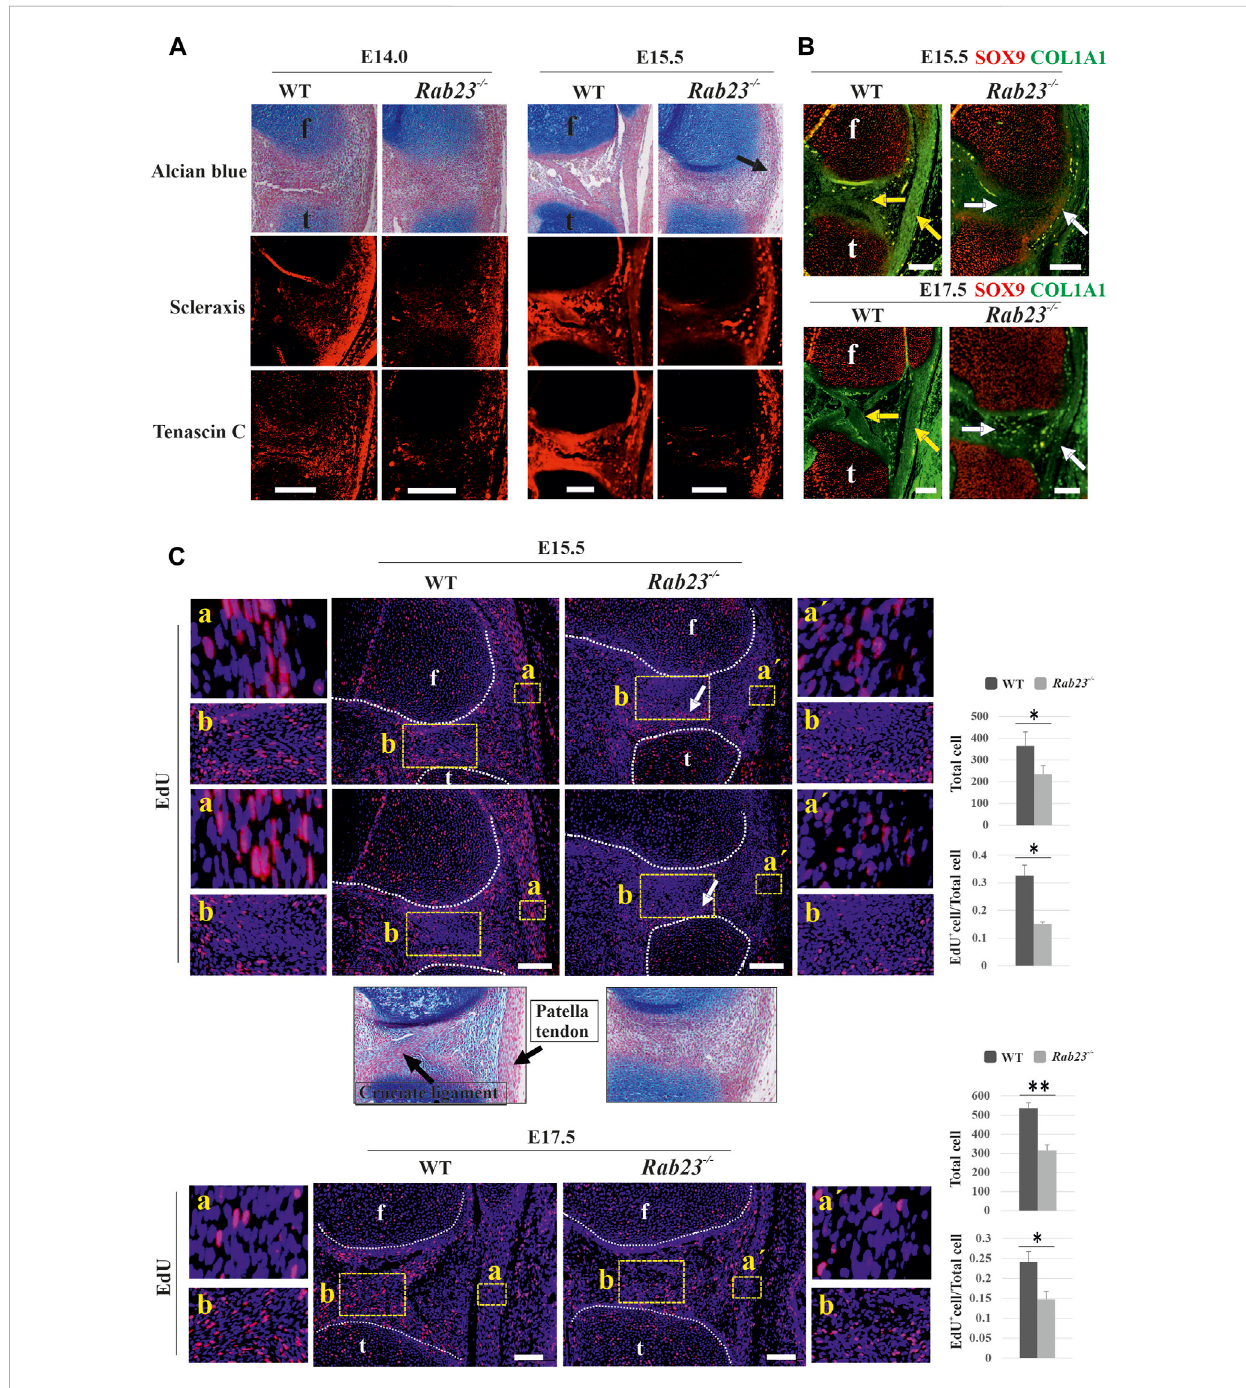
FIGURE 6 RAB23 regulates tendonogenesis and ligamentogenesis and cell proliferation in the patella tendon and cruciate ligaments. (A) Immunohistochemical expression analysis of early tenocyte-expressing marker Scx and structural protein marker Tenascin-C in the Wt and Rab23 − / − mice in the sagittal sections of hind limbs obtained from E14.0 and E15.5. Wt samples show Scx and Tenascin-C expression in the patella tendon at both the embryonic stages, where Tenascin-C con fi rms well-developed patella tendon. Rab23 − / − samples at E14.0 shows less Scx expression in the patella tendon-like structure, and as Rab23 − / − samples at E15.5 failed to develop patella and patella tendon, a musculostructure connected the femur to the tibia (arrow). Scx is expressed in this structure; however, subsequent Tenascin-C expression revealed that musculostructures are disrupted in Rab23 − / − samples. Similar to patella tendon, analysis of Scx and Tenascin-C expressions in the cruciate ligaments show that in Wt samples, both markers areexpressedwelltomarkthecruciateligaments.However,bothmarkersfailedtomarkcruciateligamentsin Rab23 − / − samples.Tohighlightthecartilage cellsofthepatella,patellatendonsagittalsectionsfromE14.0andE15.5hindlimbswerestainedwithAlcianblueandfastred(upperpanel)( n =3samples foreachageandgenotype).f:femurandt:tibia.Scalebar:200 μ m. (B) ImmunohistochemicalexpressionanalysisofSOX9andstructuralintegrityprotein of tendon and ligaments COL1A1 in the Wt and Rab23 − / − mice sagittal-sectional tissues of hind limbs obtained from E15.5 and E17.5. Wt samples show COL1A1 expression that marks the cruciate ligament and patella tendon at both the embryonic stages (yellow arrow). However, Rab23 − / − samples show COL1A1 expression that barely detected cruciate ligament at E15.5 (white arrow) and failed to demonstrate the cruciate ligaments at E17.5 (white arrow). Rab23 − / − samples failed to develop patella and showed weaker COL1A1 expression in the ligament-like structure that connects the femur and the